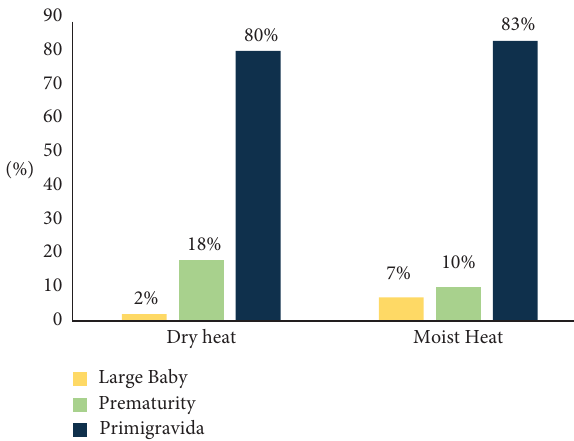
Figure 2: Graphical presentation of dry and moist heat groups according to their indications of episiotomy.